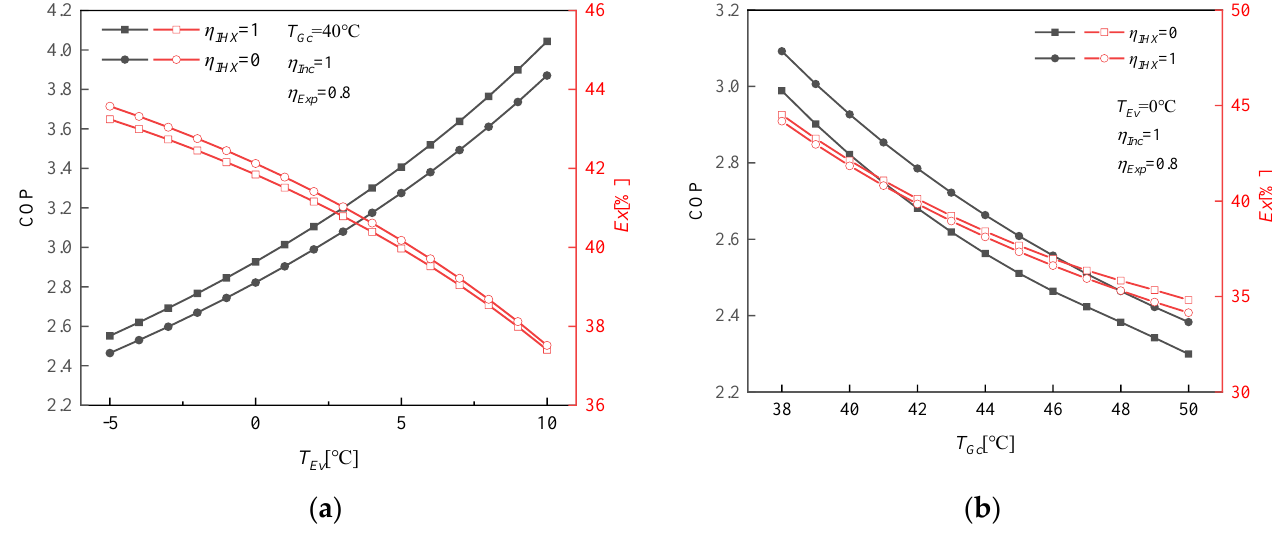
Figure 10. Effect of η IHX on system performance. ( a ) Variation with T Ev ; ( b ) Variation with T IHX on system performance. ( a ) Variation with T Ev ; ( b ) Variation with T Gc . The evaporation temperature is 0 ◦ C. Figure 10b shows that the change of the gas cooler outlet temperature on the system COP and exergy efficiency under the condition of η IHX is 0 as well as showing the complete η IHX of the system. The gas cooler outlet temperature is 35 ◦ C, and the maximum system COP is 3 and 3.1 for both systems without reheating and with full reheating, and the maximum exergy efficiency is 44.5% and